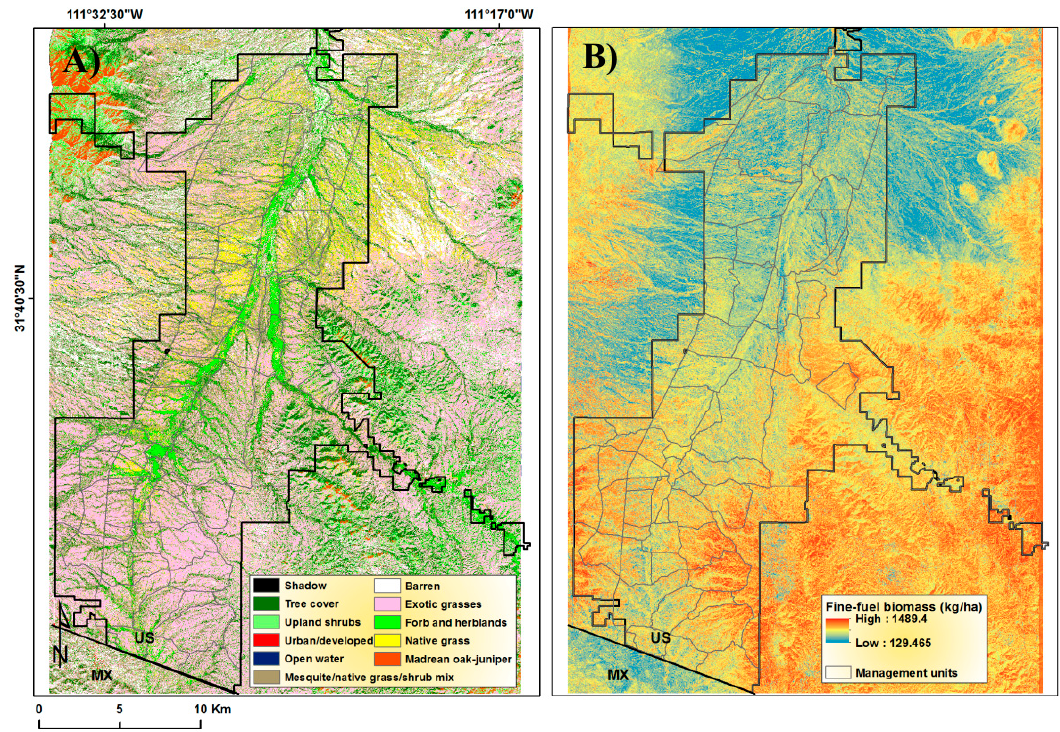
Figure 15. Modeled ( A ) land cover types from WV3 imagery and ( B ) corresponding fine-fuel biomass within the study areas in 2015. Grasslands highly invaded by the non-native grass species E. lehmaninana overlapped with areas of high fine-fuel biomass accumulation. Grasslands with a greater number of native grass species were associated with lower fine-fuel accumulations.